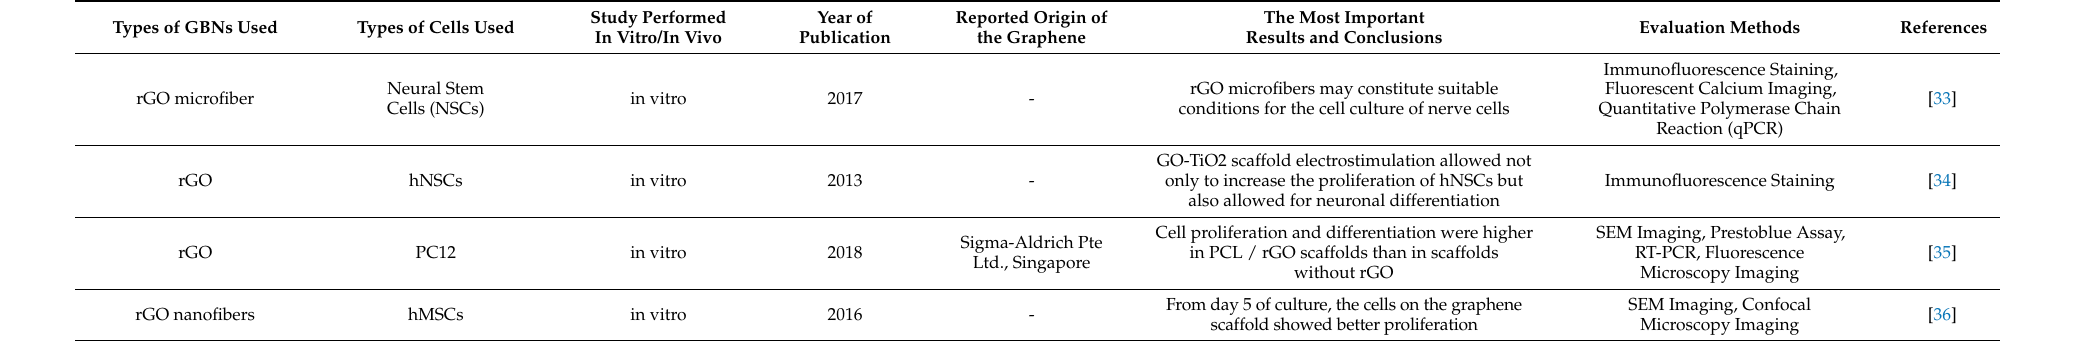
Table 2. List of relevant studies utilizing